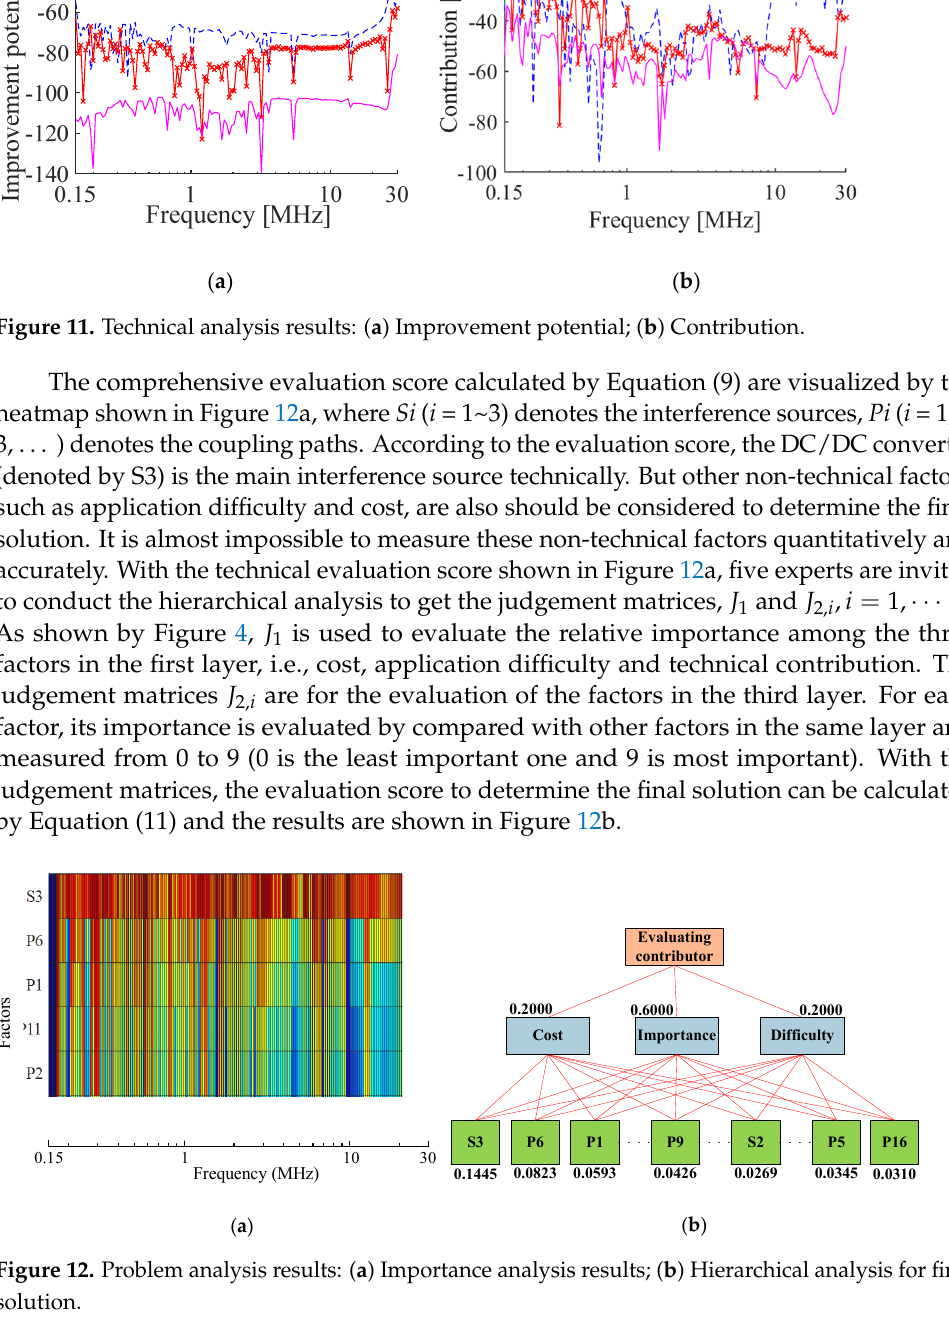
Figure 12. Problem analysis results: ( a ) Importance analysis results; ( b ) Hierarchical analysis for final